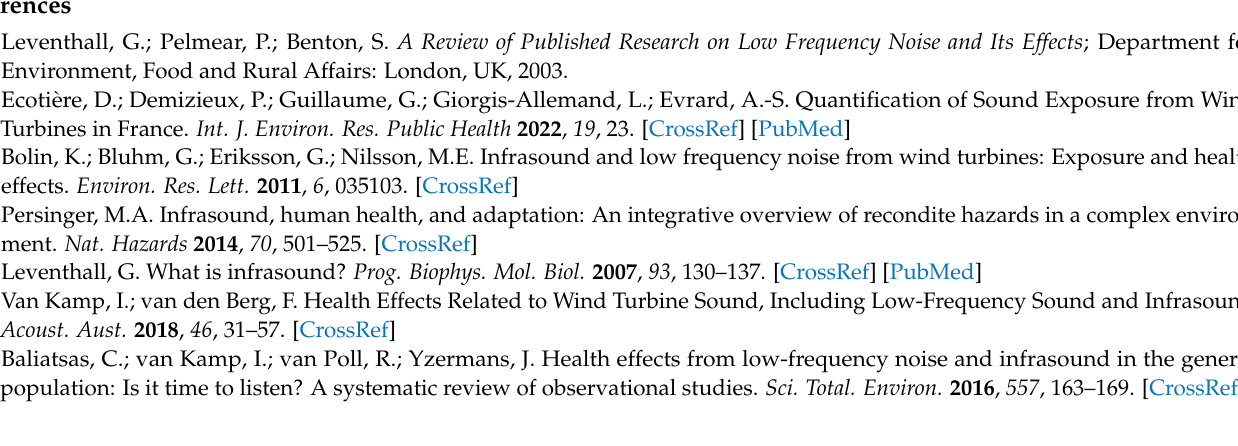
Table S3: A gamma coefficient between the noise parameters and the outcomes of the post-exposure questionnaire. Figure S1: Nominal G-, A-, C- and Z-weighting characteristics according to ISO 7196:1995 and IEC